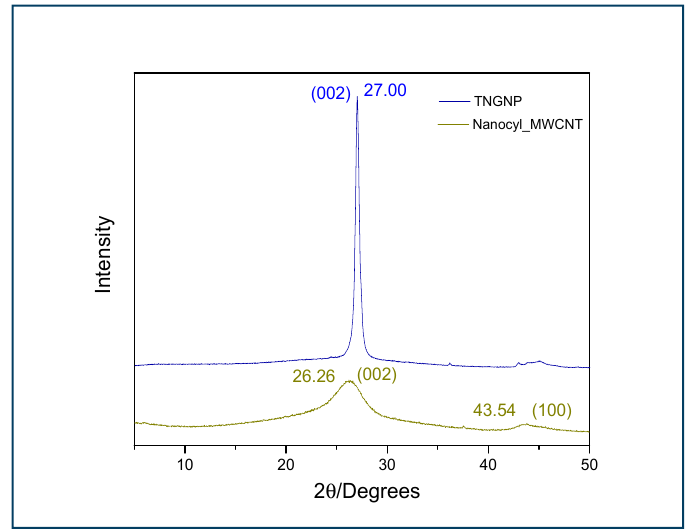
Figure 5. XRD patterns of pure graphene and carbon nanotubes.